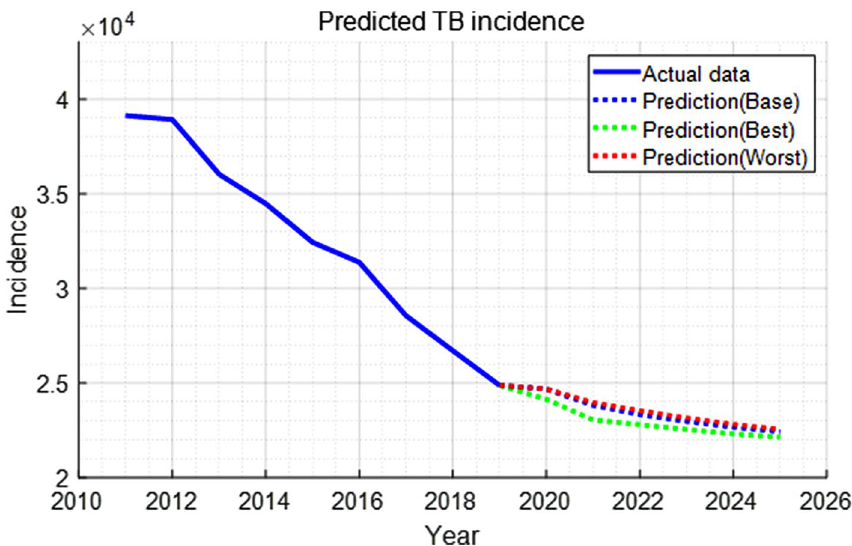
Figure 4. TB incidence data through 2019 and model forecasts for 2020–2025 under different scenarios of social distancing and health service